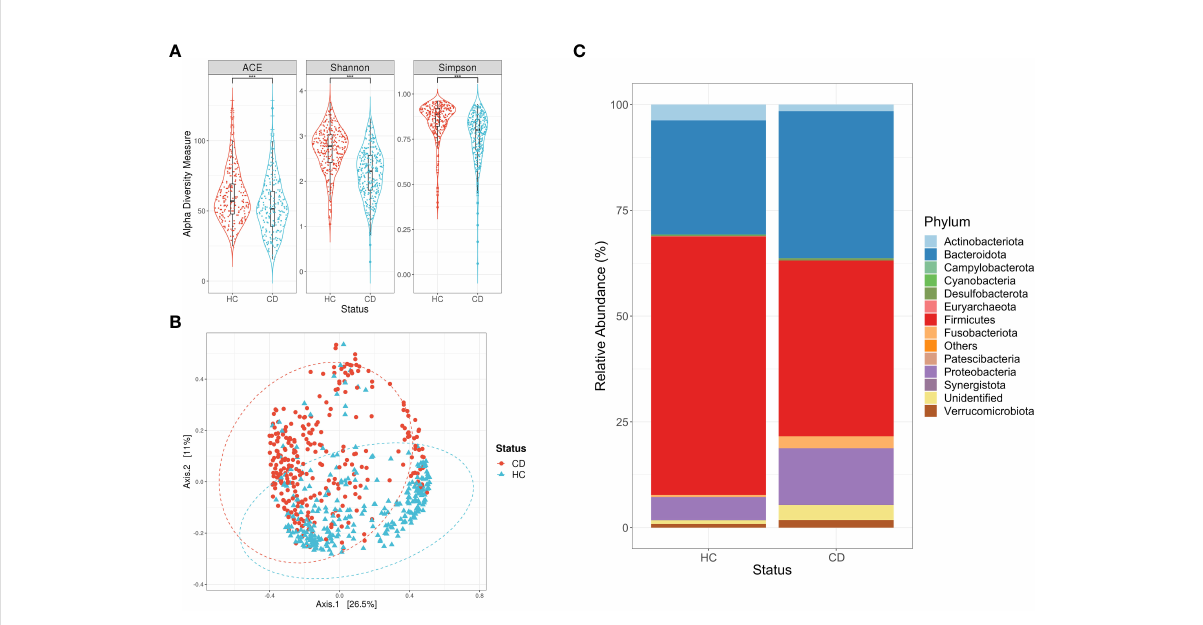
FIGURE 2 Descriptive analysis for the consolidation of studies focused on Crohn ’ s disease (CD). (A) Alpha diversity measures calculated for the ASVs of subjects with CD and their respective controls (HC). Statistical differences were evaluated with a Mann-Whitney test and a T-test (***p-vlaue <0.001). (B) Principal Coordinate Analysis (PCoA) for the ASVs of subjects with CD and their respective controls (HC). Statistical differences of beta diversity were evaluated with the adonis test (r 2 = 0.025, p-value <0.001). (C) Relative abundance of the phyla for each of the study groups, where Firmicutes is signi fi cantly reduced in CD